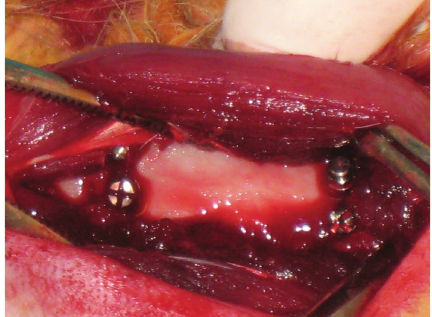
Figure 2: Four miniscrews placed in the fibula.